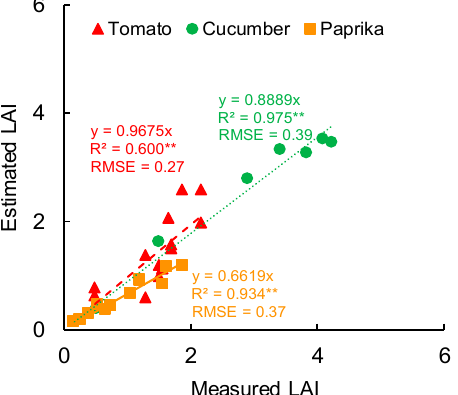
Figure 8. Relationship between measured and estimated leaf area index (LAI). LAI was measured non-destructively using the leaf area (leaf area = leaf length × leaf width × coefficient) and cultivation area. LAI was estimated based on the polygon area of the canopy surface model and cultivation area. Tomato and cucumber canopies were scanned using the 3D scanner (DPI-8X, Opt Technologies Co., Ltd., Tokyo, Japan) from 7 April to 23 May 2019. Paprika canopy was scanned from 7 April to 12 June 2019. ** significant at p < 0.01 according to the regression analysis. LAI, leaf area index. RMSE means root mean squared error.